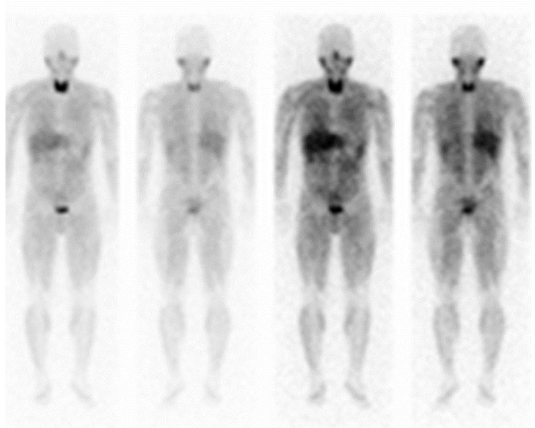
Figure 1. Abdominal computed tomography (CT) image of the patient in this case. Abdominal CT image during the first outpatient visit. Left adrenal adenoma (25 mm in diameter and 40 household- units) is shown (white arrow).